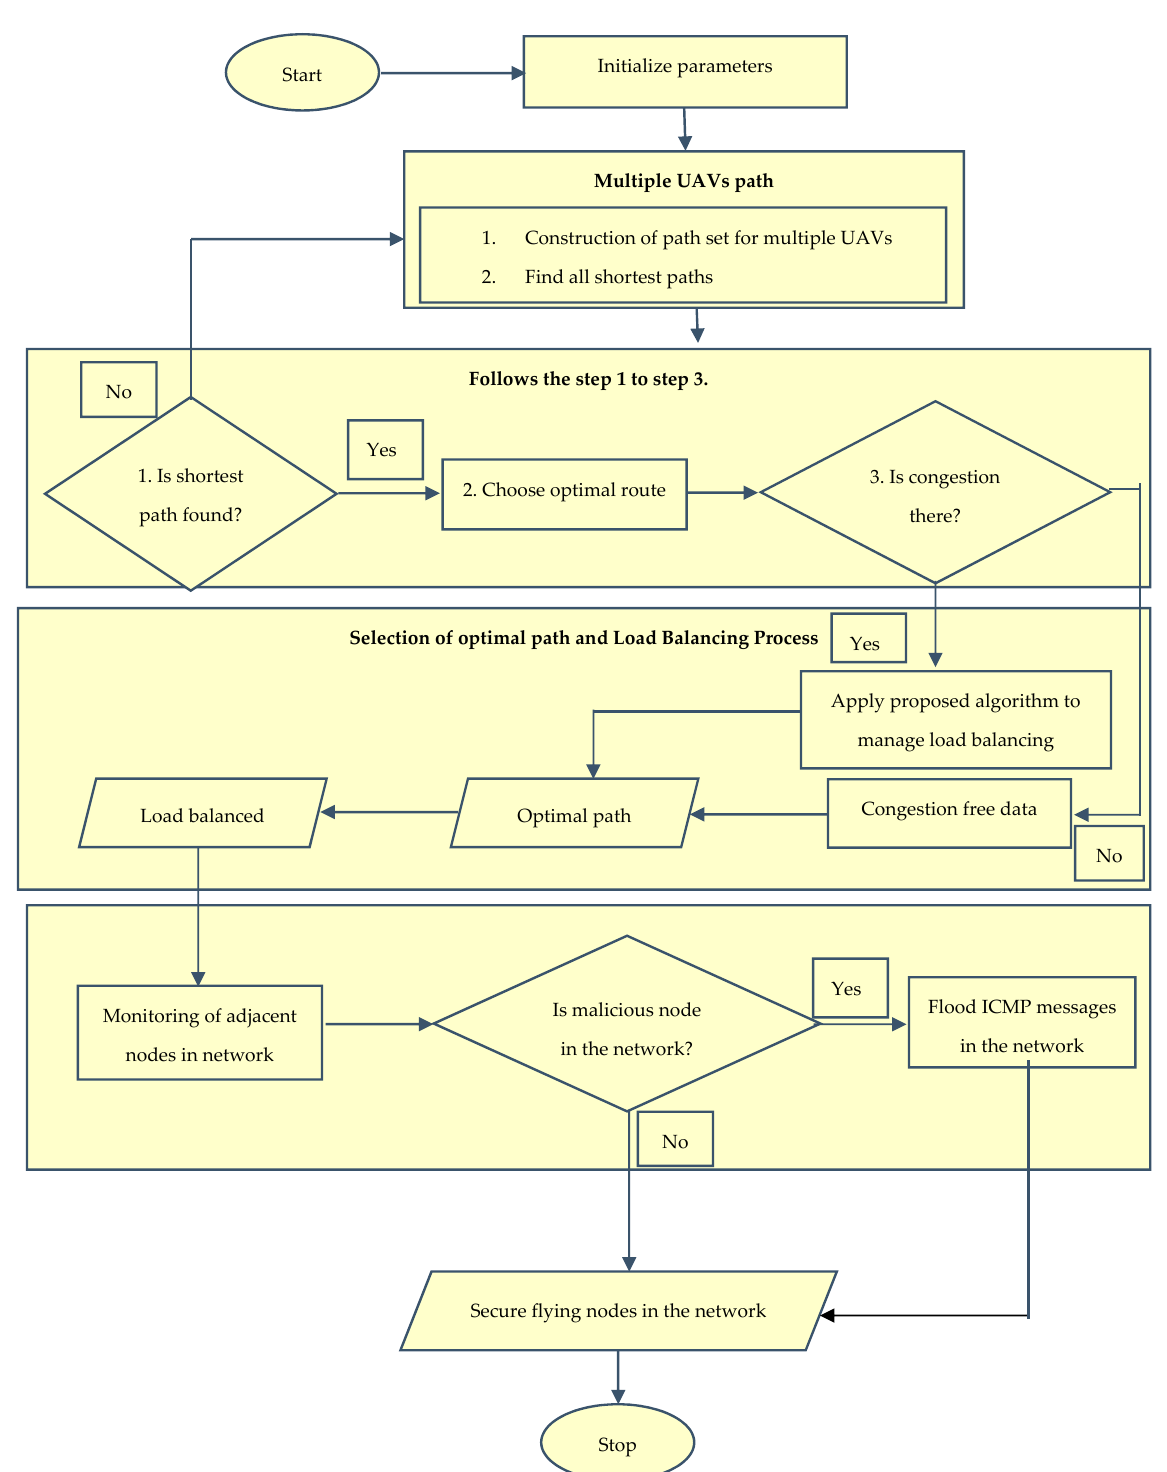
Figure 2. Load balancing and secure flying nodes in the network.